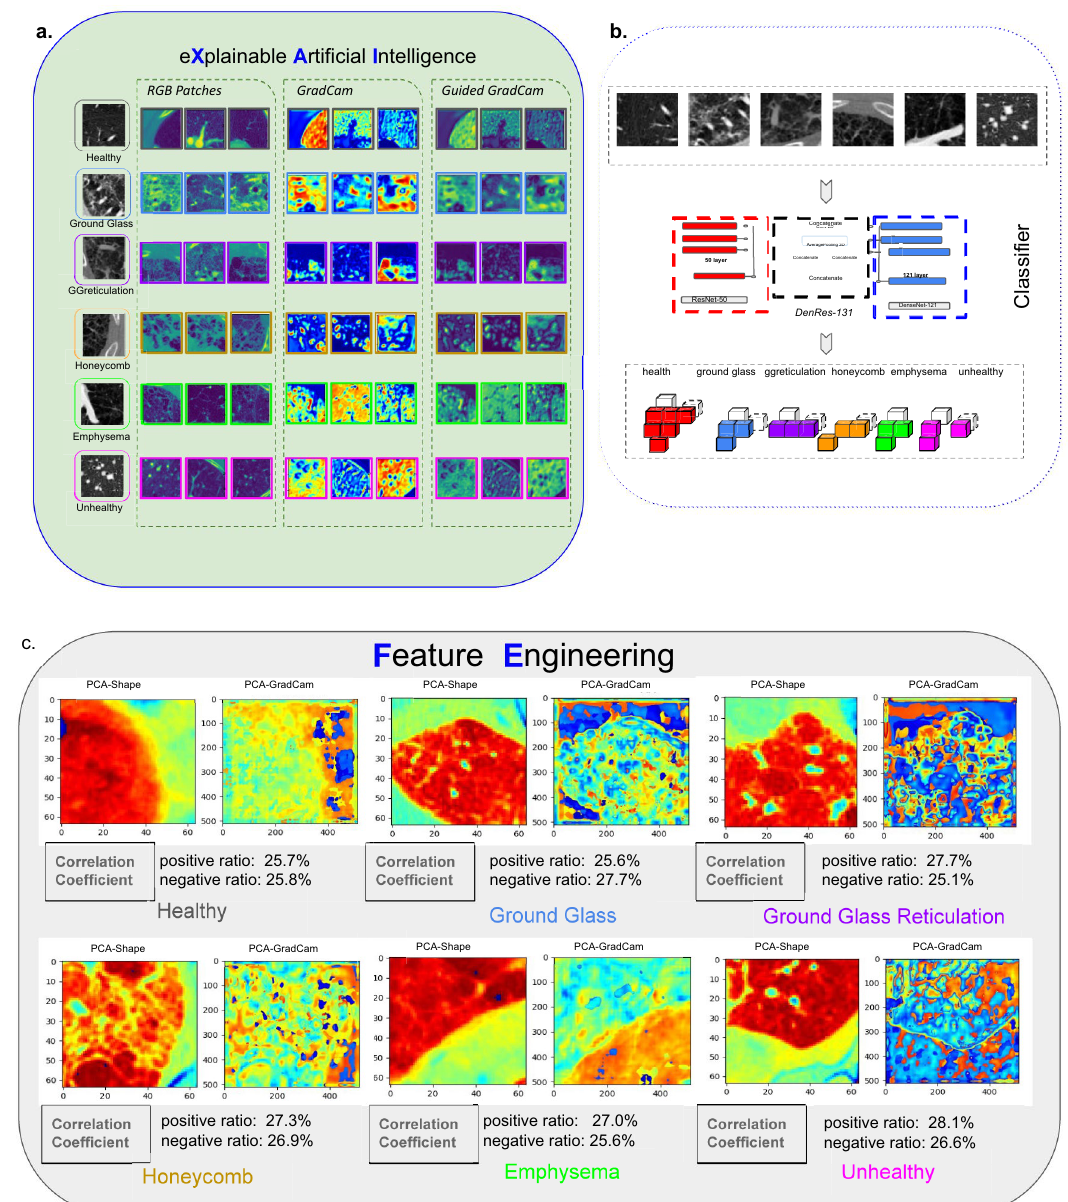
Figure 6. The local explainability results of DenRes-131 and the 32 × 32 × 3 patch size of the multi- classification task. ( a ) The colorful RGB patches, GradCam, and guided GradCam results of the six classes (healthy, ground glass, ground glass reticulation, honeycomb, emphysema and unhealthy). ( b ) the structure of DenRes-131 network. ( c ) The PCA zero component of the patch images (PCA-Shape) and GradCam results (PCA-GradCam) of each class for a four components analysis. The correlation coefficient between the PCA- Shape (Average image) and the PCA-GradCam (PCA GRADCAM) with the negative and positive ratio is